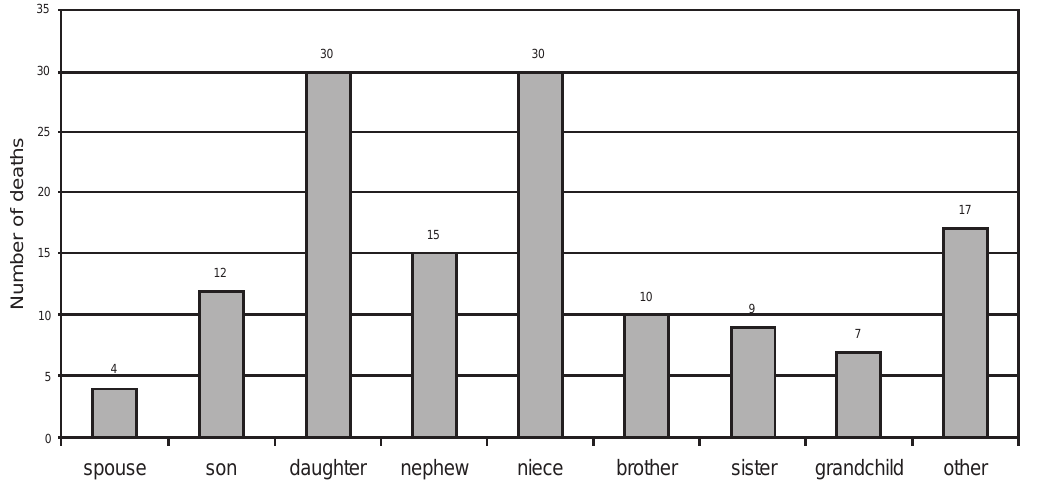
Fig. 2. Grandmothers’ family members who had recently died.